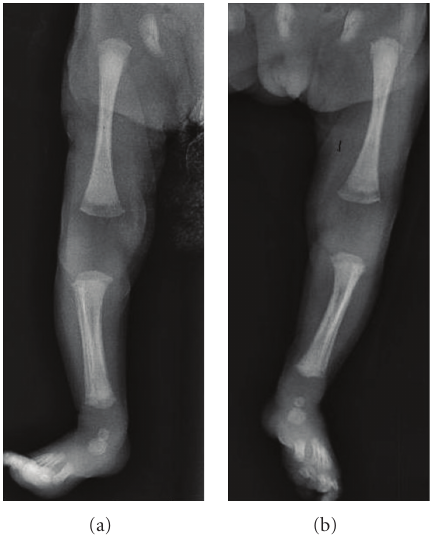
Figure 2: X-ray examination of the long bones of the case